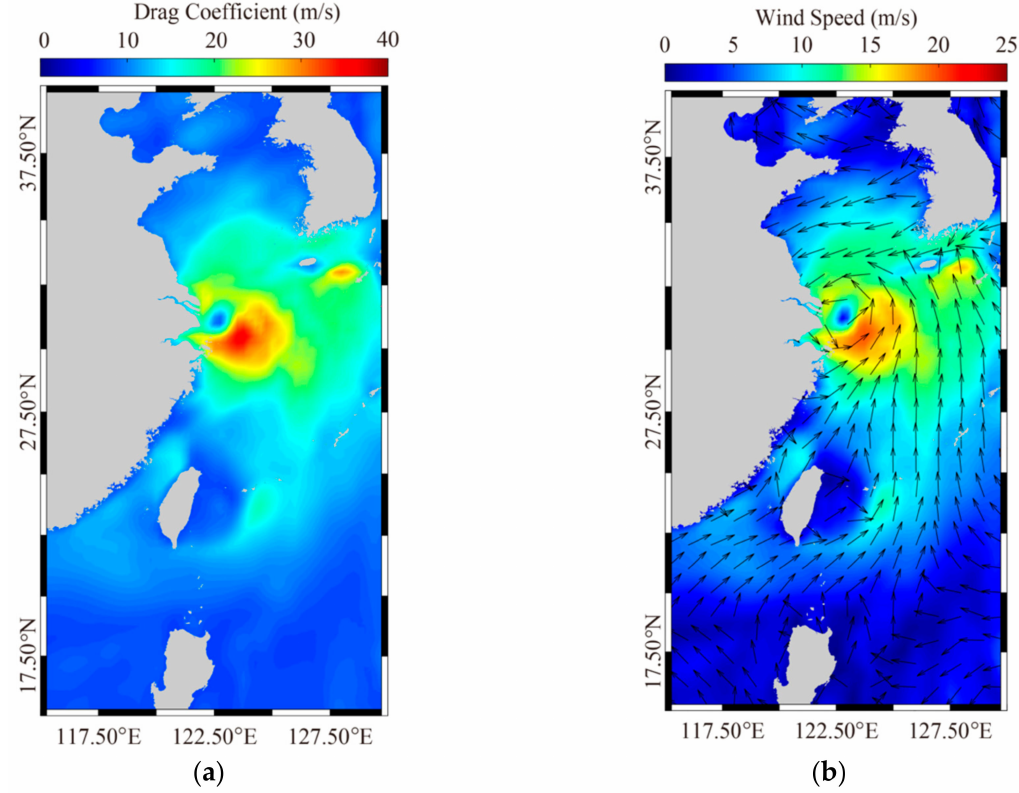
Figure 7. ( a ) The case of the drag coefficient C d map using the refitted values in Equation (7). ( b ) The wind speeds were derived from the 0.1 ◦ gridded composite wind field at 20:30 UTC on 1 October